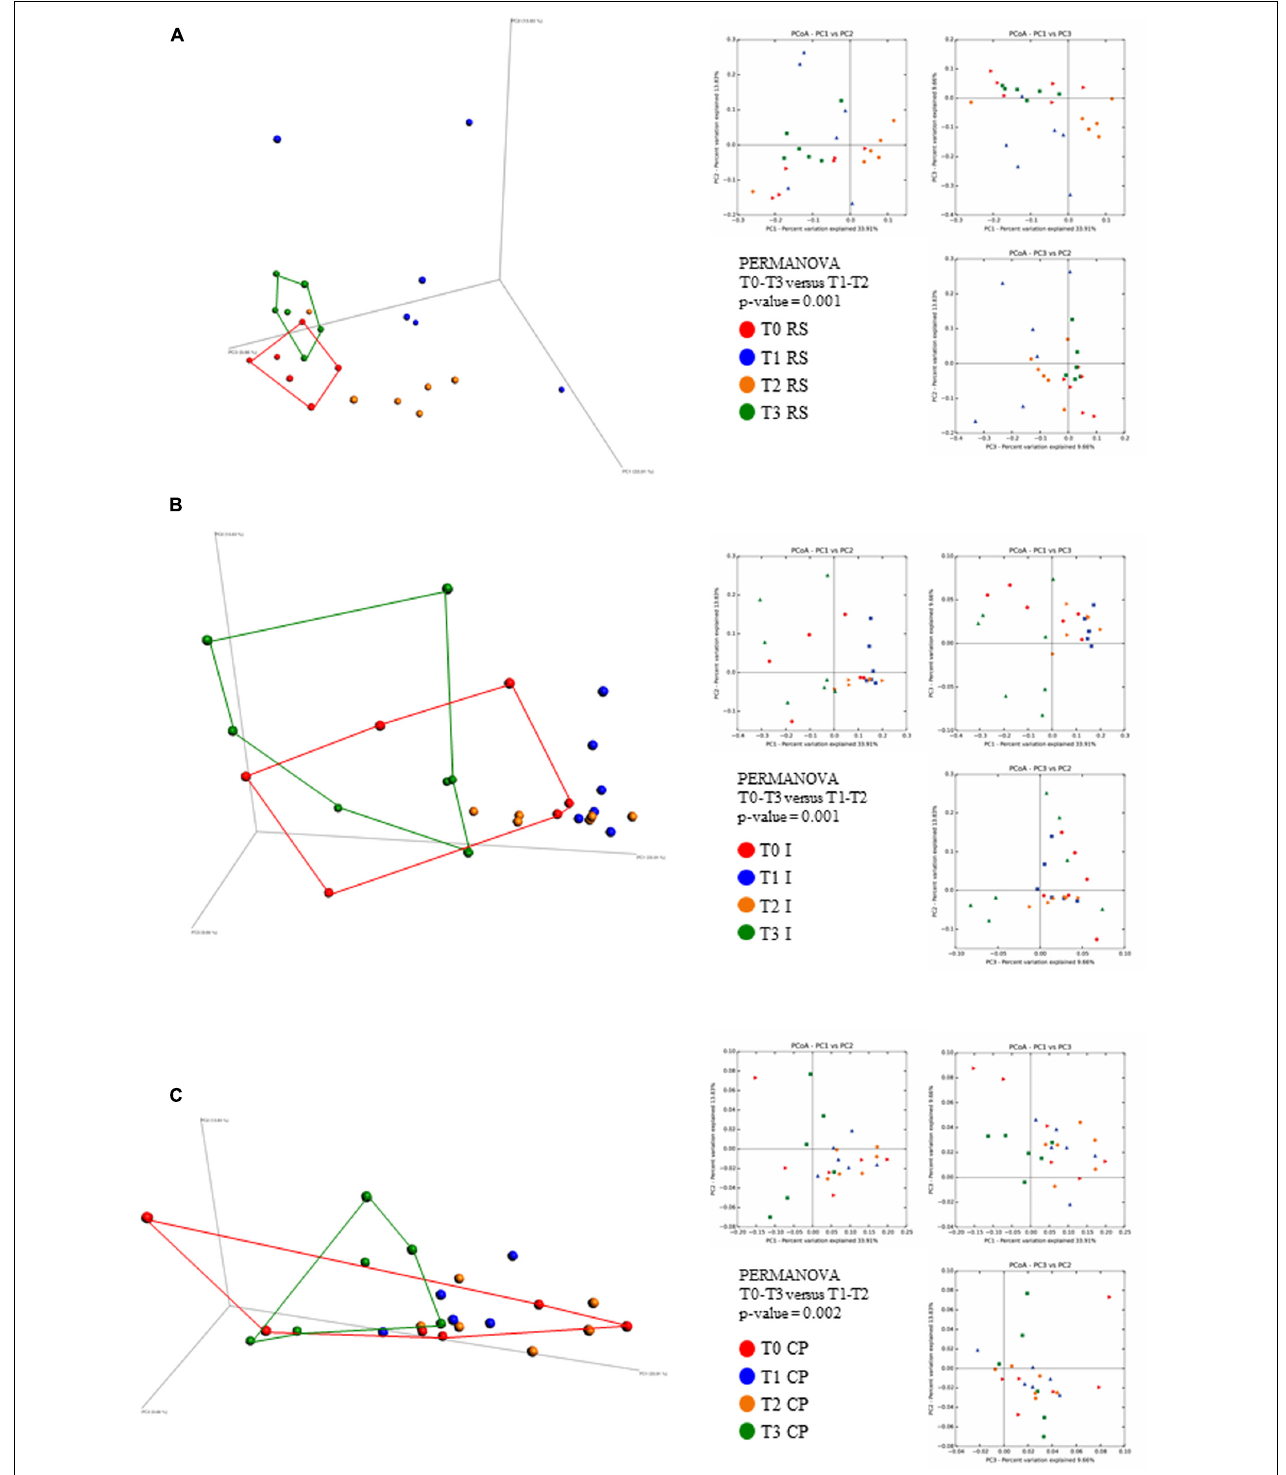
FIGURE 2 | Evaluation of beta-diversity of the three sample sets. The predicted PCoA plots represent weighted UniFrac beta-diversity measures, encompassing all 72 fecal samples, are reported via three-dimensional images as well as two-dimensional sections. The three panels report the compositional analyses obtained for the three dietary fibers supplements (RS, A ; I, B ; and CP, C ) at four different time points and are colored in red for time point 0 (T0), in blue for time point 1 (T1), in yellow for time point 2 (T2), and in green for time point 3 (T3).